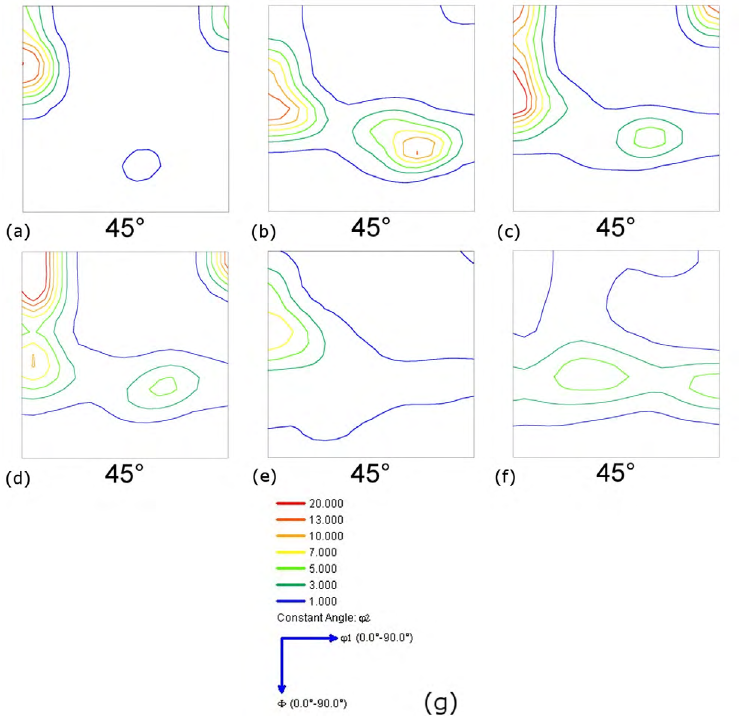
Figure 7. ODFs maps for specimens of the 430Nb steel at conditions (a)CR, (b)T1, (c)T2, (d) T4, (e)T5 and (f)A, respectively. (g) levels. Constant sections of φ2=45º